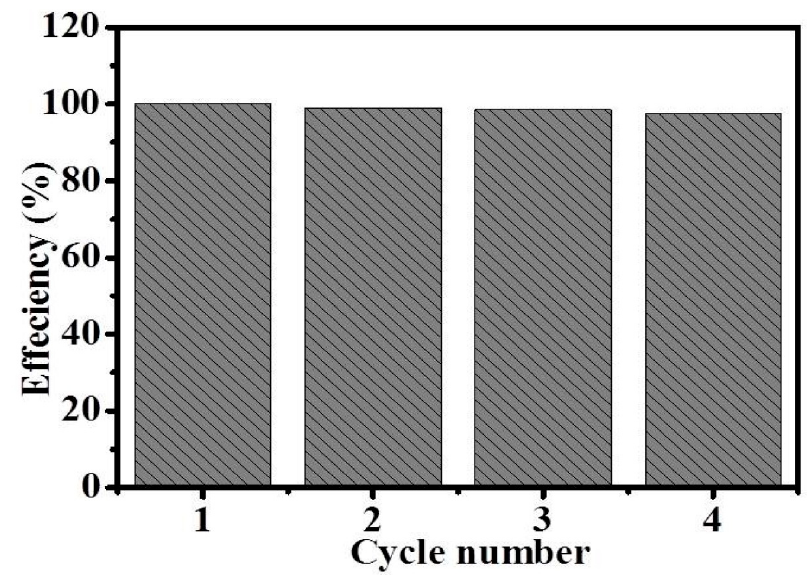
Figure 5. Reusability test of composite NFs.